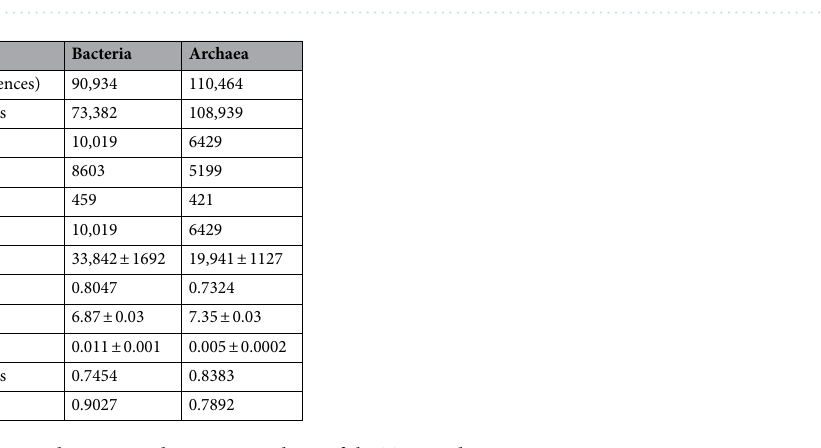
Table 3. Coverage, diversity and evenness indices of the Tirez sediment in